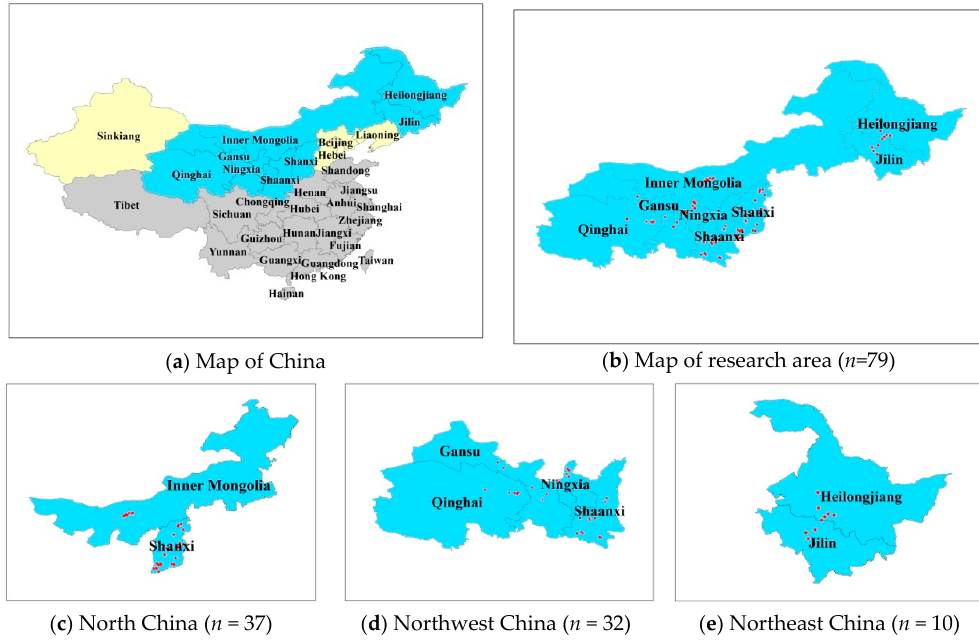
Figure 1. Sketch map of research areas and sampling points in northern China. ( a ) Sketch map of research areas; the blue and yellow areas denote northern China, with the blue indicating the research area of this article. ( b ) Sampling points in northern China ( n = 79), including Northwest China, North China, and Northeast China. ( c ) Sampling points in Northwest China ( n = 32), including Shaanxi, Ningxia, Gansu, and Qinghai Provinces. ( d ) Sampling points in North China ( n = 37), including inner Mongolia and Shanxi Provinces. ( e ) Sampling points in Northeast China ( n = 10), including Heilongjiang and Jilin Provinces. Note: n denotes the number of sampled organic fertilizer enterprises.